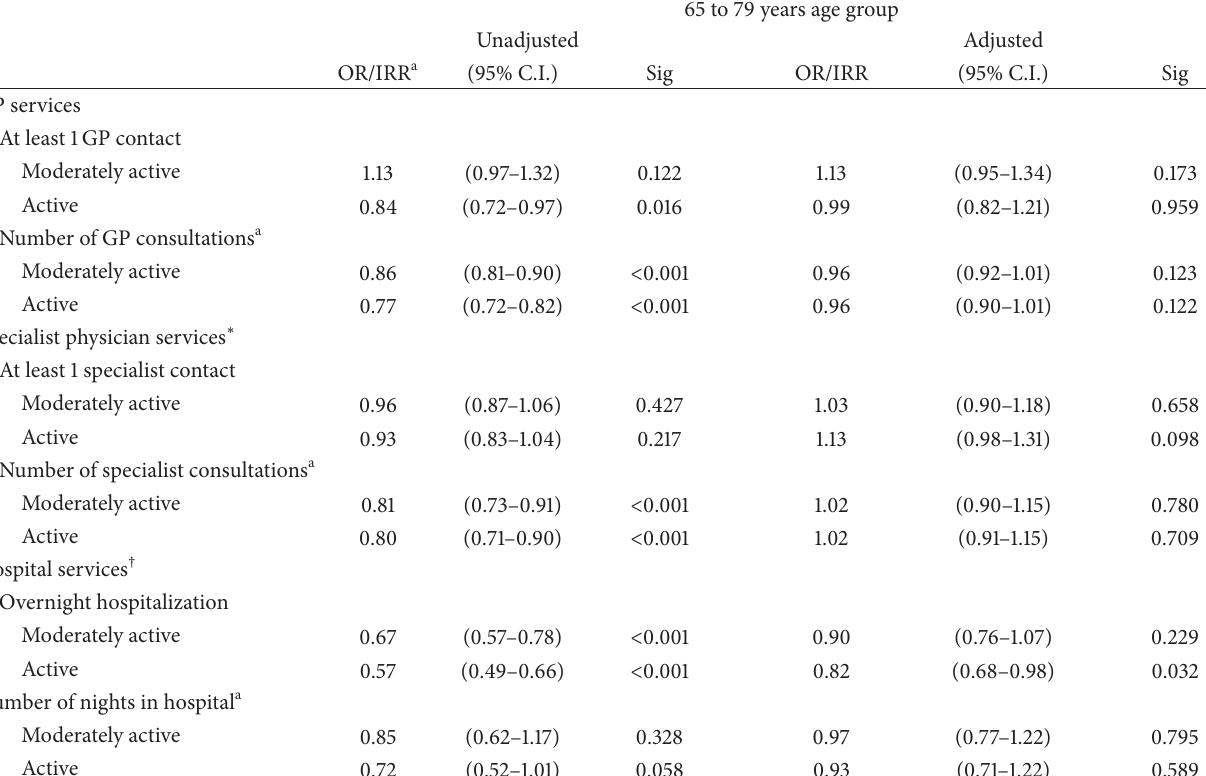
Table 5: The association between LTPA and health services utilization in the 65 to 79 years age group ( 𝑁 =